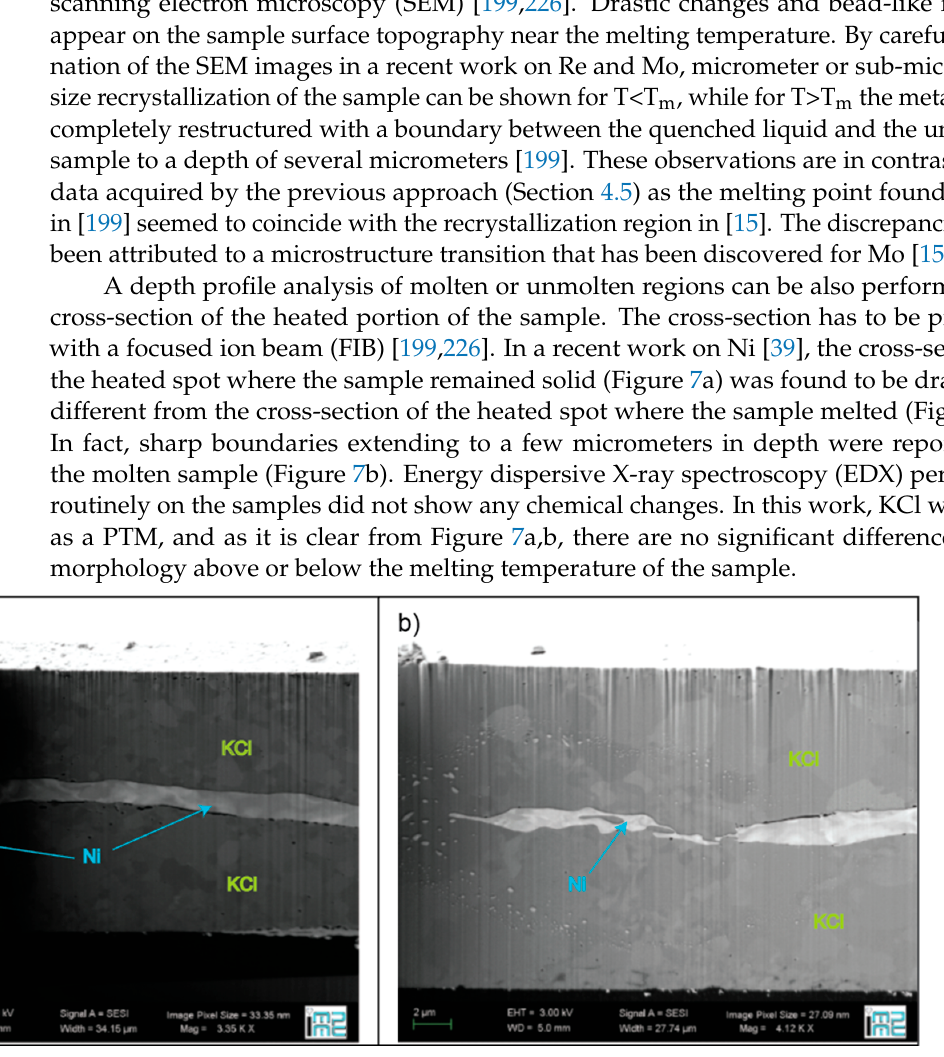
Figure 7. SEM image of the cross-section of a Ni sample heated ( a ) below melting and ( b ) above melting temperature (reproduced from [39]). In Figure 7a, cuts at different depths are shown so the three-dimensional structure of the sample assembly can be better visualized.